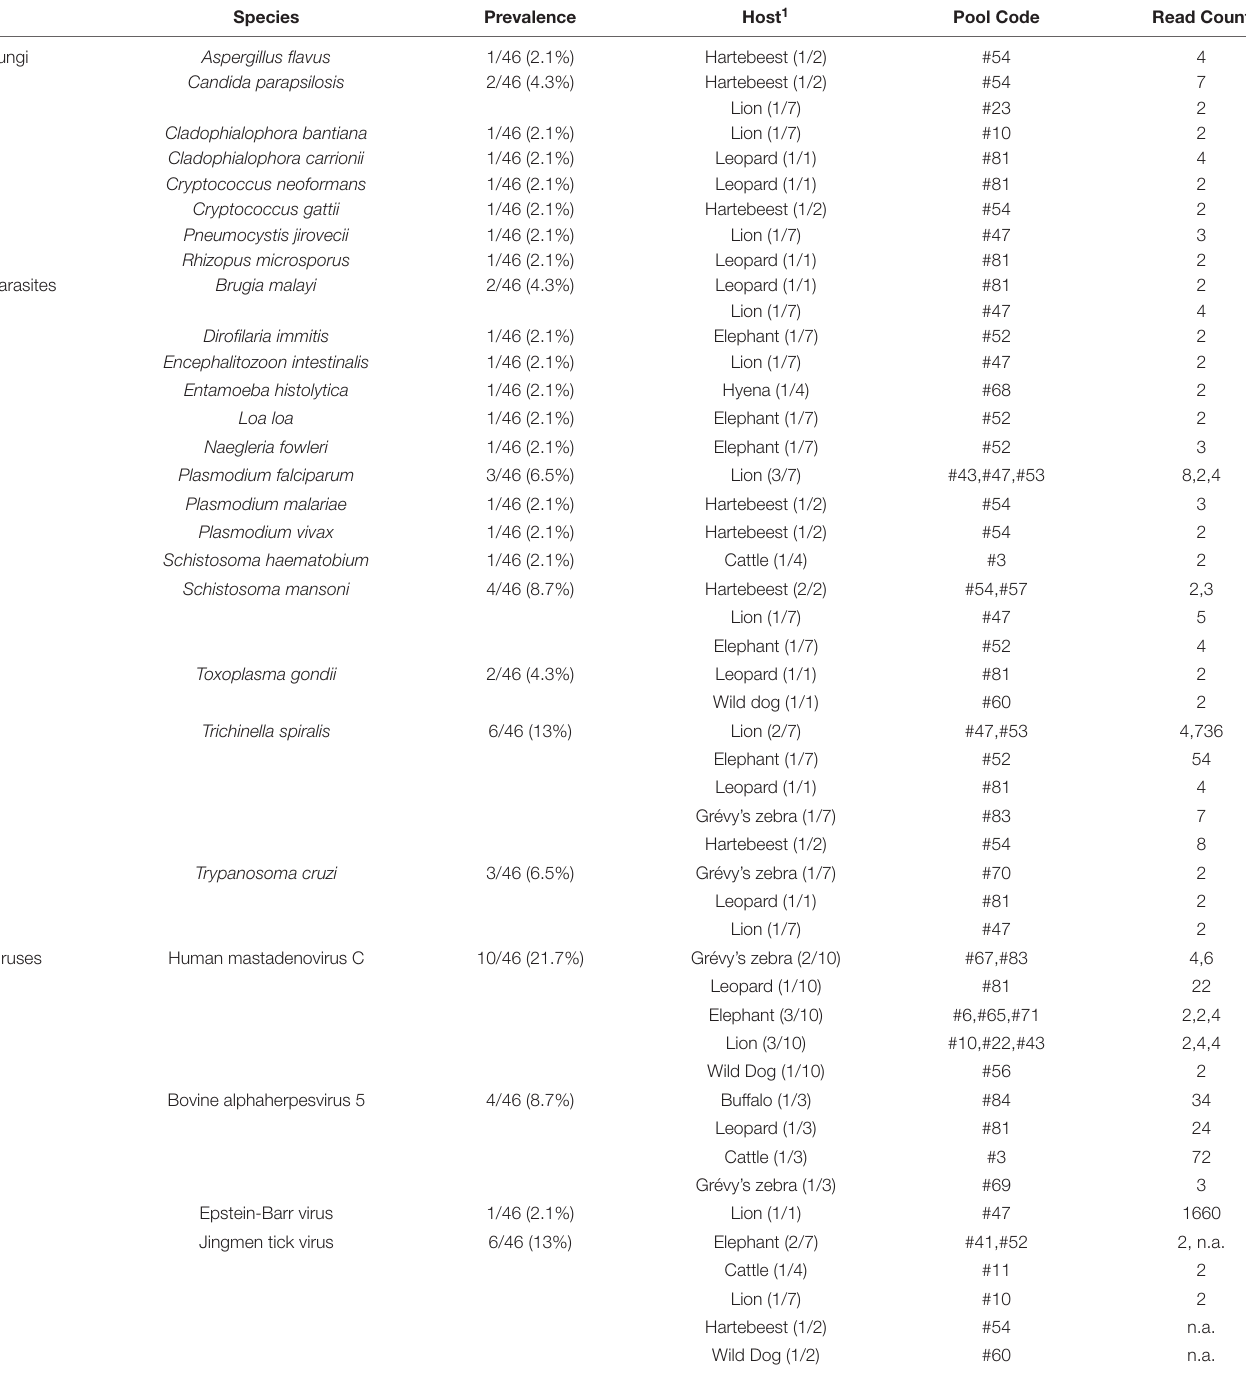
TABLE 2 | Overview of non-bacterial pathogens detected in tick pools.